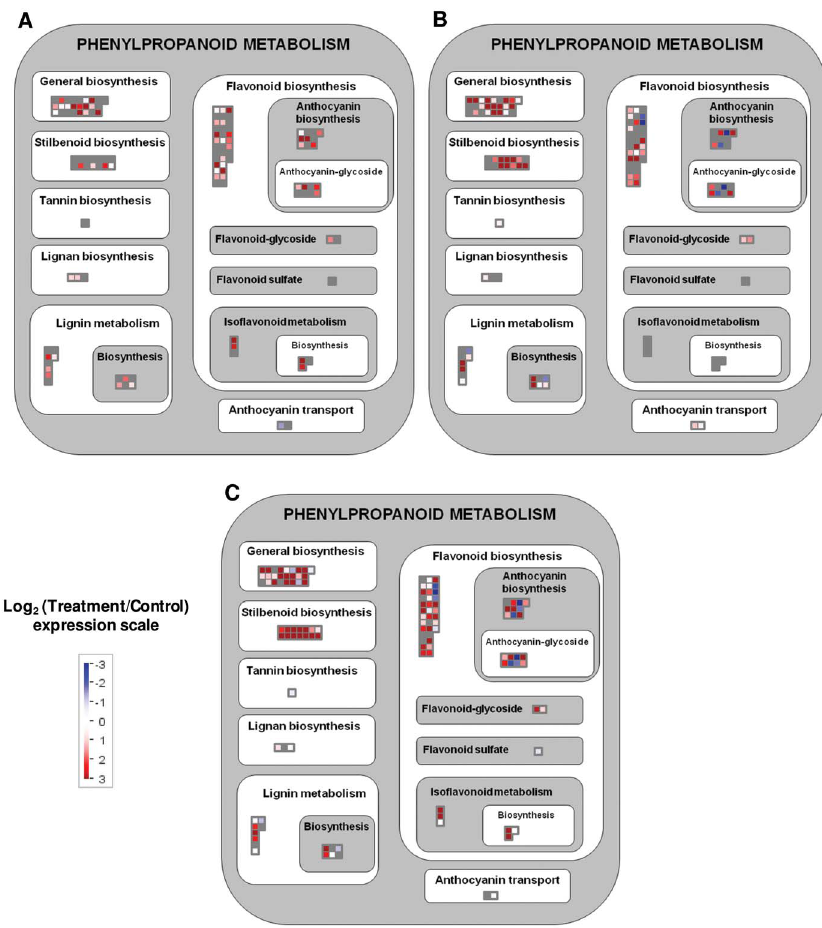
Figure 4. Mapman visualization of the significant genes in the ‘Phenylpropanoid metabolism’ pathway. A, MJ (methyl jasmonate); B, CD (cyclodextrins); C, CDMJ (cyclodextrins and methyl jasmonate). Resultant transcripts were considered after the average of significant redundant probesets expression values. Significant probesets according to a 5% FDR and P -value , 0.05 for model variable in the corresponding control versus treatment 24 h series maSigPro comparison. Expression changes in the treatment normalized to these in the control are shown. Red, treatment up- regulated transcripts; blue, treatment down-regulated transcripts; grey, transcripts not significant in the treatment.